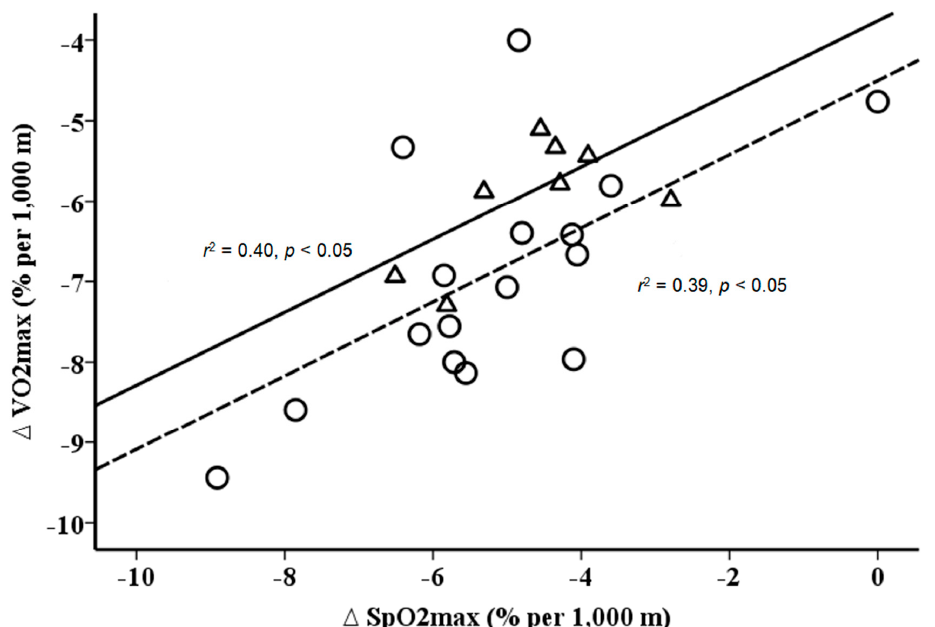
Figure 3. Relationship between changes (%) in peripheral oxygen saturation during maximal exercise (SpO 2max ) and maximal oxygen uptake (VO 2max ) per 1 km gain in altitude. Solid line (triangles) for hypobaric hypoxia ( r 2 = 0.40, p < 0.05) and dashed line (circles) for normobaric hypoxia ( r 2 = 0.39, p < 0.05). Delta values are calculated as HH/NH values minus sea level values.